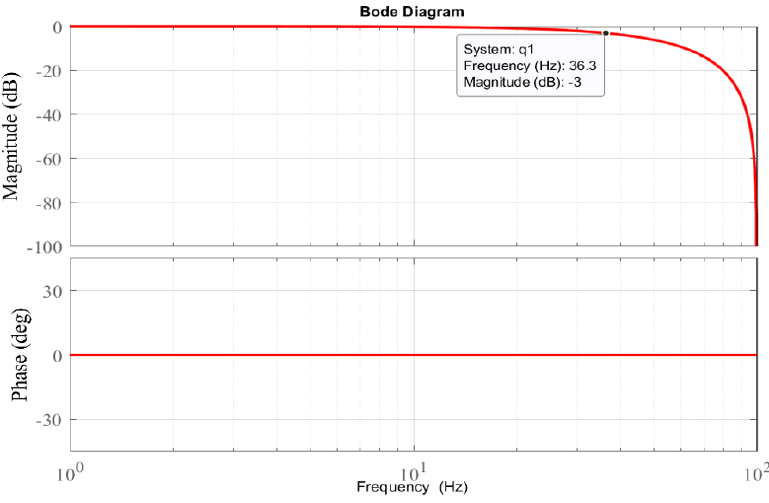
Figure 7. Magnitude and phase responses of the q − filter